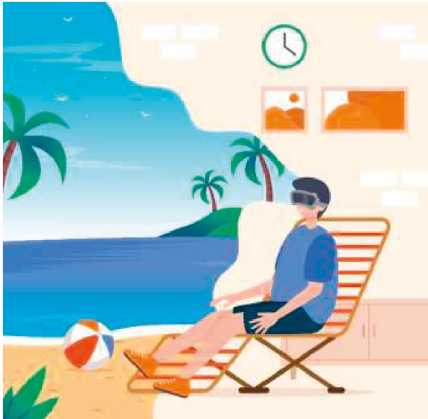
Figure 6: Concept of virtual tours using virtual reality within a metaverse that can be incorporated into a metaverse [33].